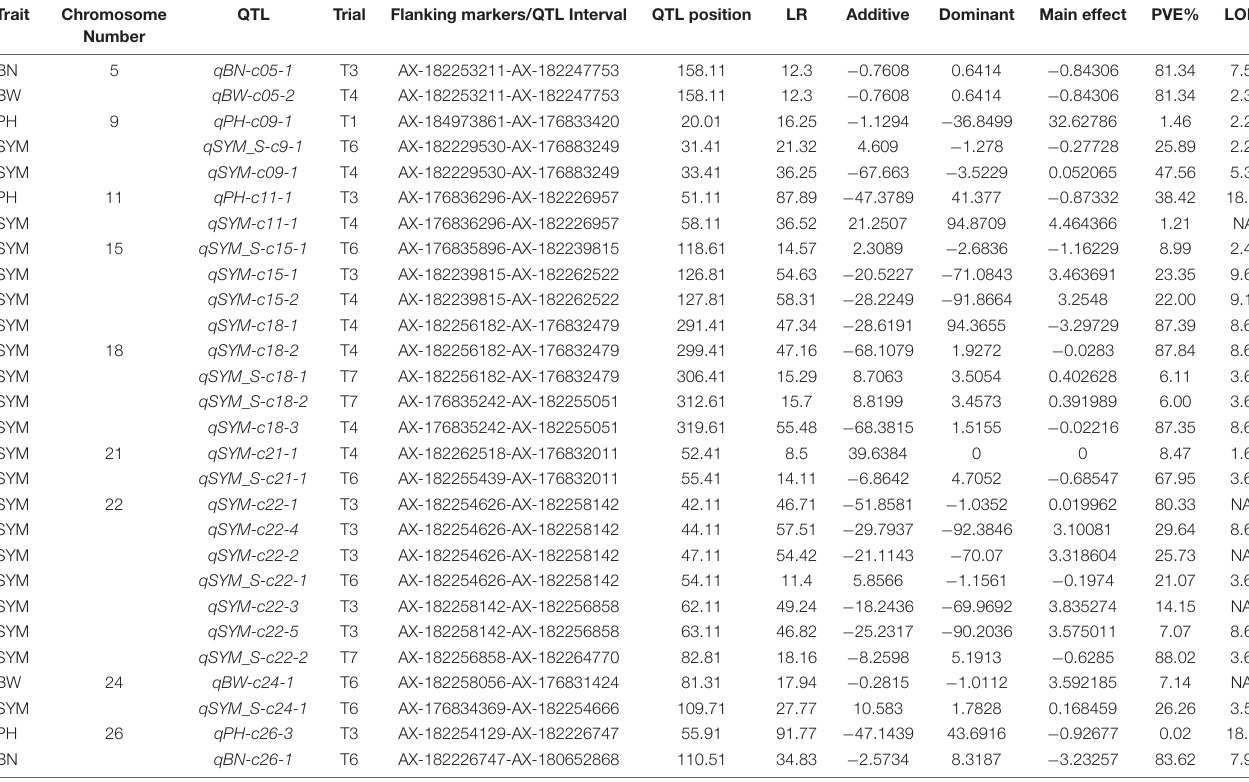
TABLE 6 | Identification of co-localized, stable, and major QTL for the investigated traits in this study.